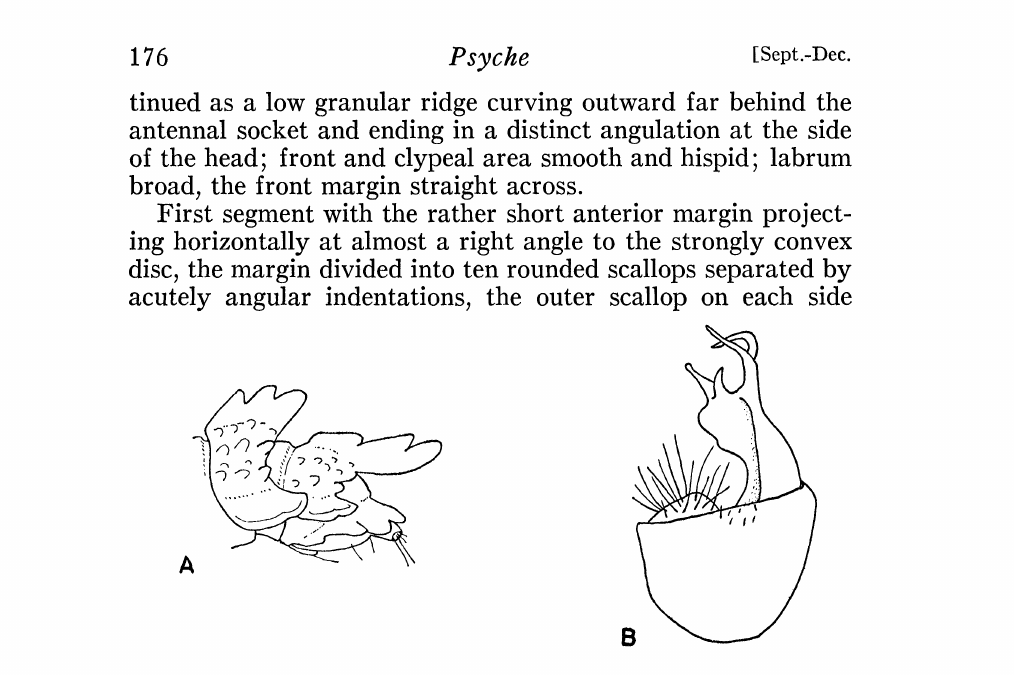
Fig. 6. Ilyma cajuni, a, Segments 18, 19 and 20, lateral view; b,